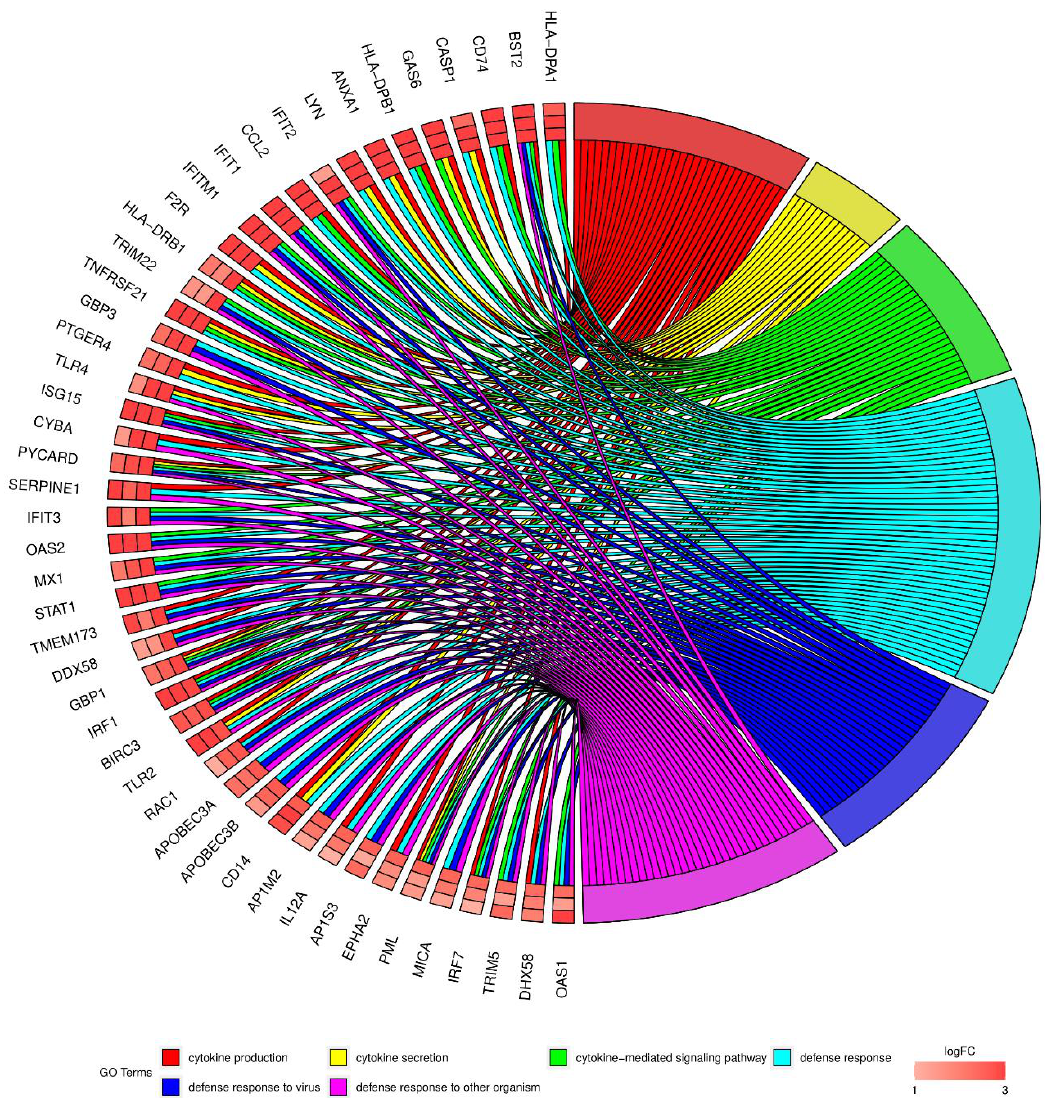
Figure 4. Analysis of enriched Gene Ontology groups involved in cytokine action and metabolism-mediated signaling pathway activity during immunological defense processes in human cumulus-oophorus cells (CCs). The network plot presents the linkages of genes and GO BP terms.